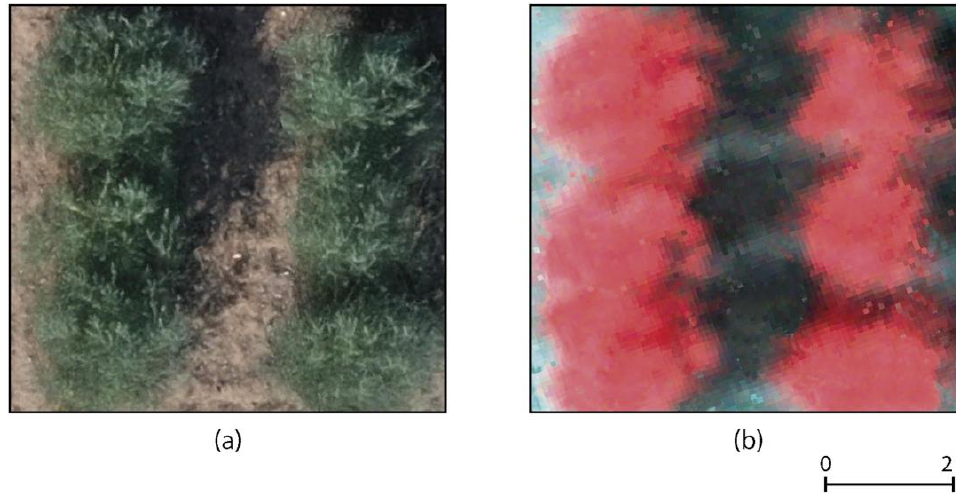
Figure 3. Partial view of ( a ) RGB and ( b ) hyperspectral orthomosaic of the study area.